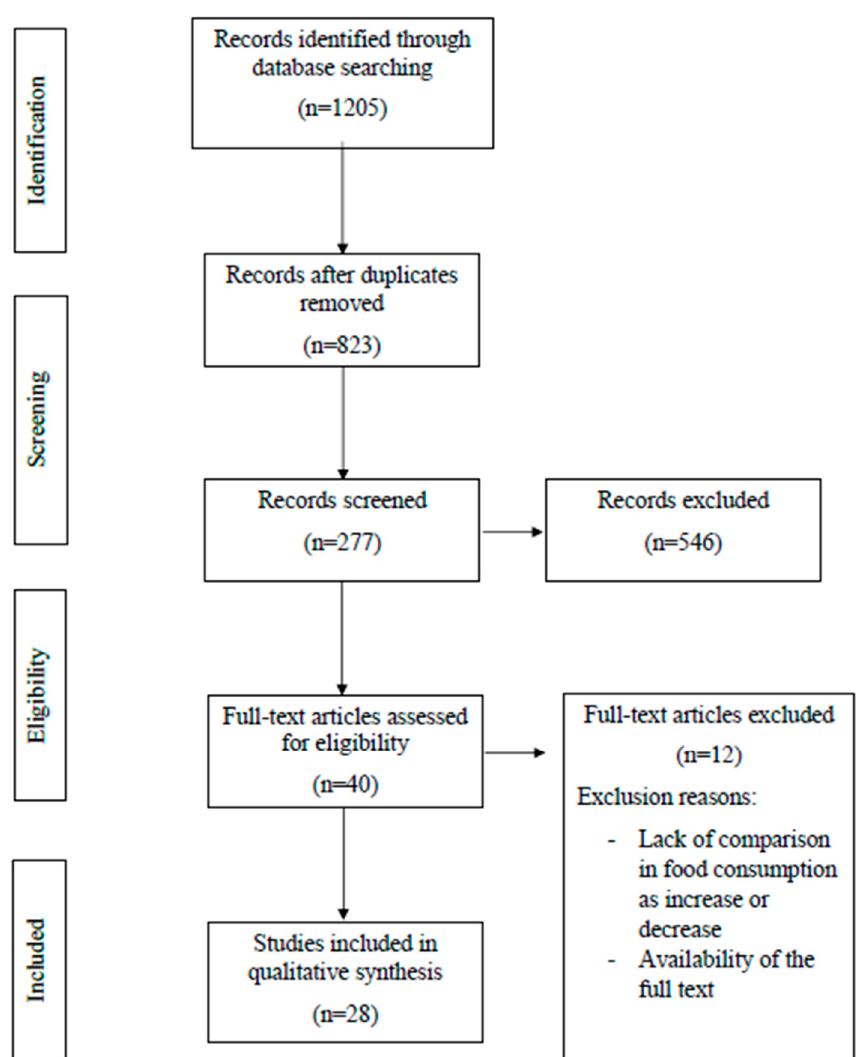
Figure 1. Flowchart of the literature screening process. Details of the design (cohort or cross-sectional), sample size (N) and sex ratio (%), minimum age or age range, setting (community or hospital), and country of the individual studies are shown in Table 2. The cross-sectional outnumbered the longitudinal design, whereas the recruitment settings were primarily community-based (100%, N = 28). The geographic distribution of studies spanned, in descending order of study prevalence, Europe (N = 19/28), America (N = 5), Asia (N = 3/28), and Africa (N = 1). Subjects were adults (18+) in most of the selected studies (23 of 28 studies, or 82%). Among all 123 , 608 subjects in the studies, gender was poorly balanced (approximately 33% males), and the geographic distribution of subjects ran through the following ascending order: 2970 African; 7132 Asian; 51 , 509 American; and 61 , 997 European. Concerning the representativeness of the sampling, the majority of studies used non-probability online surveys, i.e., river sampling, only two studies used telephone questionnaires [33,35], and just one survey enrolled participants within a school-based setting [44]. In total, 103 food and beverage entries belonging to the UPFs category, which were investigated in studies as single or food group consumption questions by the Food Frequency Questionnaire